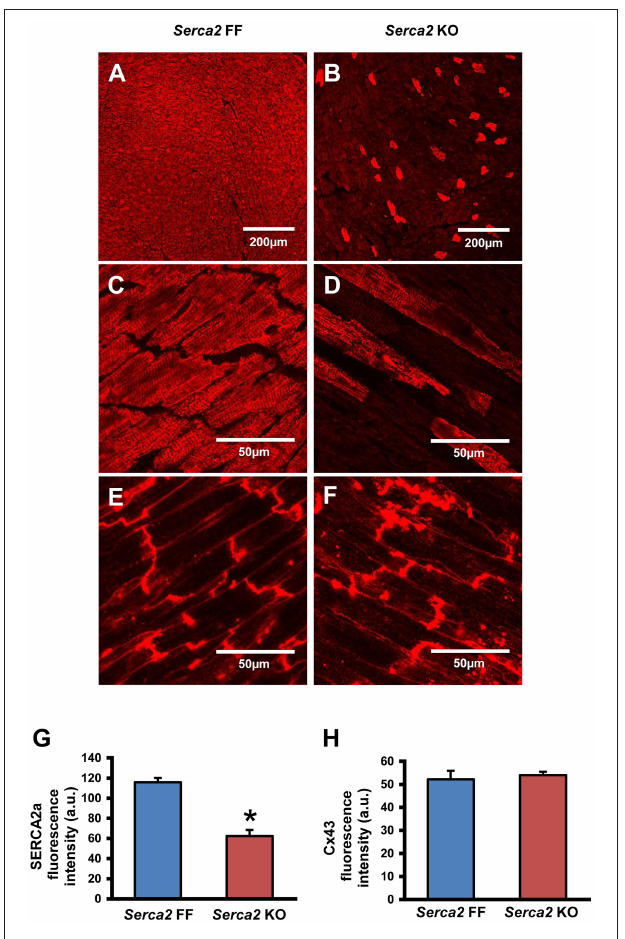
FIGURE 3 | Immunohistochemical detection of SERCA2a and Cx43 in ventricular myocardium. (A–D) Representative immunofluorescence images of SERCA2a protein labeling (red signal) in ventricular myocardium of Serca2 FF (A,C) and Serca2 KO (B,D) hearts. (E,F) , high magnification images of Cx43 expression in ventricular myocardium of Serca2 FF and Serca2 KO hearts. (G,H) bar charts showing mean SERCA2a (G) and Cx43 (H) content in the ventricular myocardium of Serca2 FF (blue bars; n = 4) and Serca2 KO (red bars; n = 6) hearts. * P < 0.05 vs. Serca2 FF.